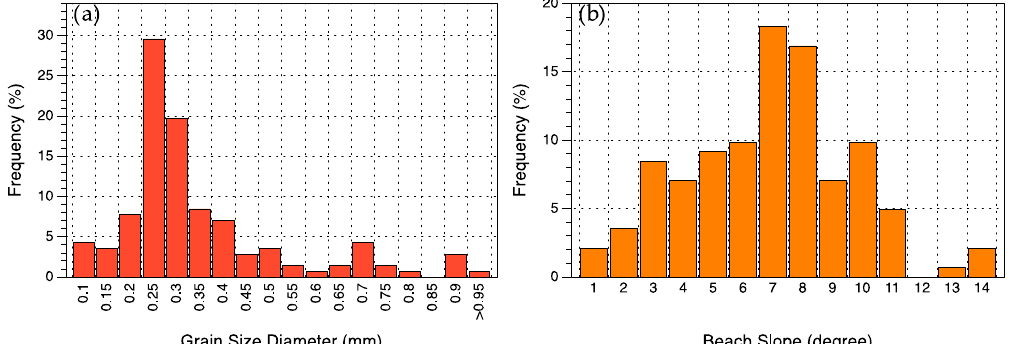
Figure 3. Frequency distributions of the present beach width and the Future (2080–2100) beach width for four Representative Concentration Pathway (RCP) scenarios.